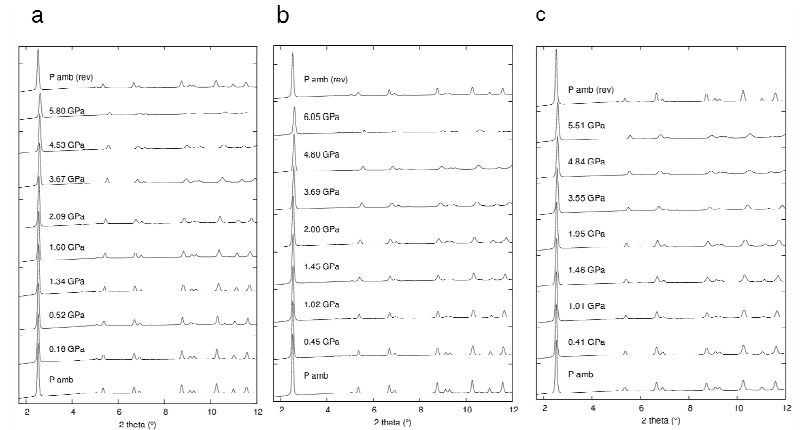
Figure 4. Selected integrated powder patterns (in the 2 θ range 3°–12°) of ZL/0.5FL ( a ), ZL/1FL ( b ) and ZL/1.5FL ( c ) compressed in s.o., reported as a function of pressure. The powder patterns at the top ( P amb (rev)) is collected upon pressure release.